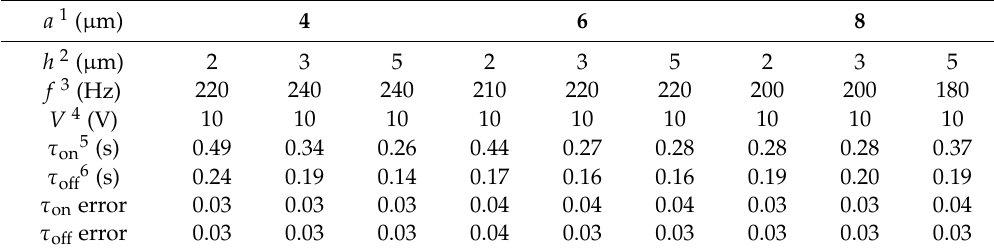
Figure3. Theelectro-opticalmeasurementwhenvaryingthediameter a andheight h ofpillars. ( a )Diffraction Figure 3. The electro-optical measurement when varying the diameter a and height h of pillars. ( a ) patterns with cylindrical pillars. The height of pillars is h = 2 µ m, the cell thickness is d = 3.8 µ m, and the LC Diffraction patterns with cylindrical pillars. The height of pillars is h = 2 μ m, the cell thickness is d = mixture consists of NCB-53 / CCN-47 / CCN-55 (50 / 25 / 25). ( b ) The frequency-dependent transmittance curves 3.8 μ m, and the LC mixture consists of NCB-53/CCN-47/CCN-55 (50/25/25). ( b ) The frequency- at h = 3 µ m. The green dotted lines indicated by the green arrows show the difference of optical intensity. dependent transmittance curves at h = 3 μ m. The green dotted lines indicated by the green arrows ( c–e ) The rising time τ on and falling time τ off . The values of the response time and applied frequency are show the difference of optical intensity. ( c–e ) The rising time τ on and falling time τ off . The values of the shown in Table 1. Cell thickness is d = 9.3 µ m and V = 10 V in ( b – h ). ( f ) Chirality shown in POM images of response time and applied frequency are shown in Table 1. Cell thickness is d = 9.3 μ m and V = 10 V LC with a = 4, 6, 8 µ m with the same applied field. in ( b–h ). ( f ) Chirality shown in POM images of LC with a = 4, 6, 8 μ m with the same applied field. Table 1. The measured response times in Figure